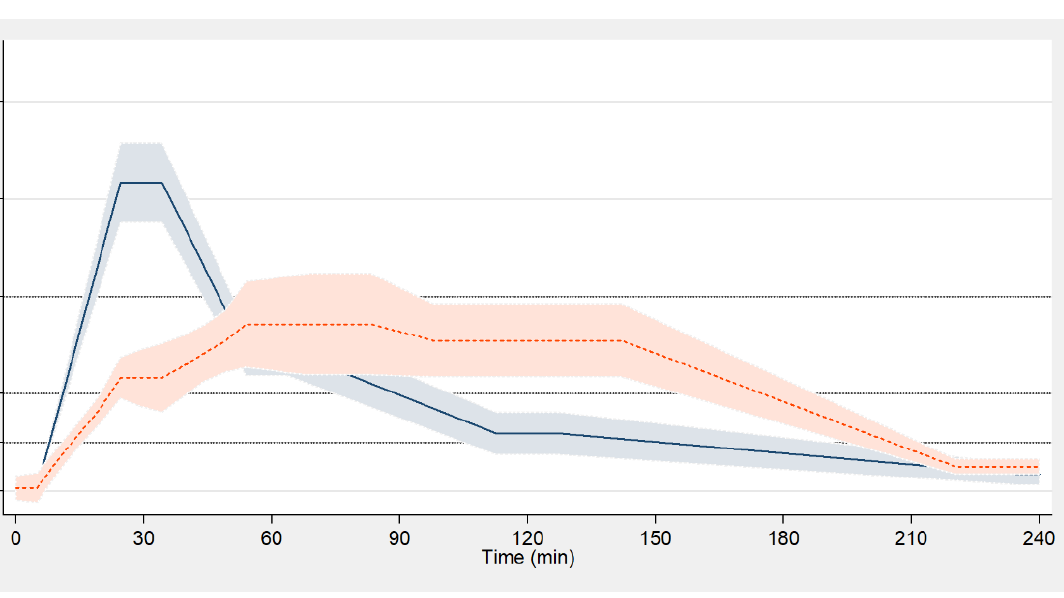
Figure 1. Pharmacokinetics of meropenem (color printing). Pharmacokinetics are presented as polynomial smoothed line with 95% confidence interval. Patients who received meropenem over 30/120 min are blue-/orange-colored, respectively.